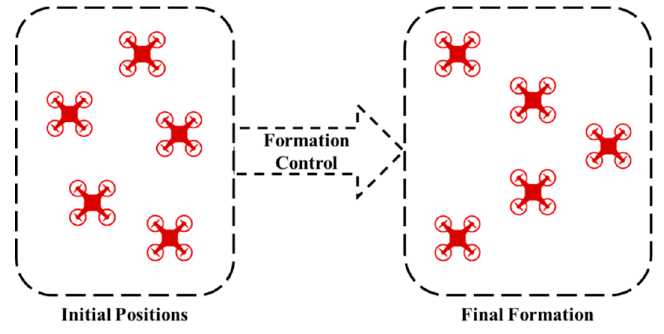
Figure 2. Before and after applying formation control on 5 agents.